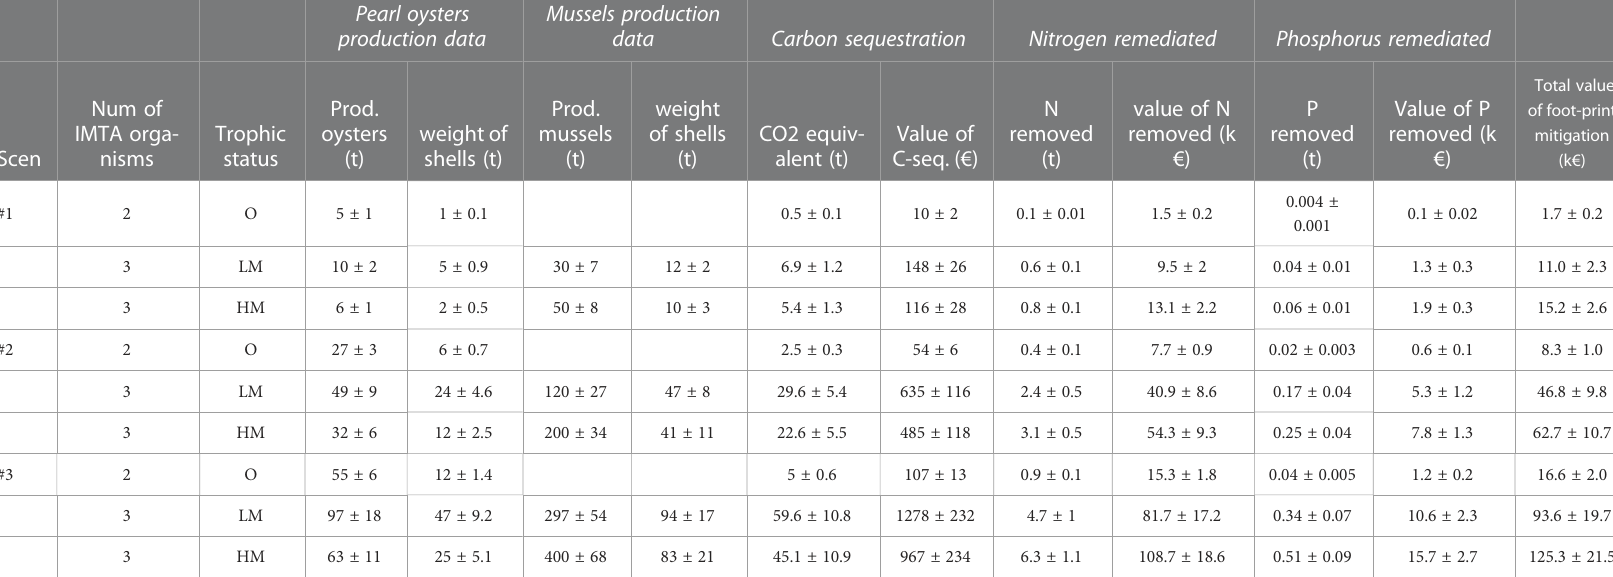
TABLE 1 Estimation of the footprint mitigation from the application of IMTA systems for three different fi sh farm sizes (Scenario 1: small fi sh farm - 250t/y; Scenario 2: medium fi sh farm - 800t/y; Scenario 3: large fi sh farm - 1600t/y) and different trophic status (O, oligotrophic; LM, low mesotrophic; HM, high